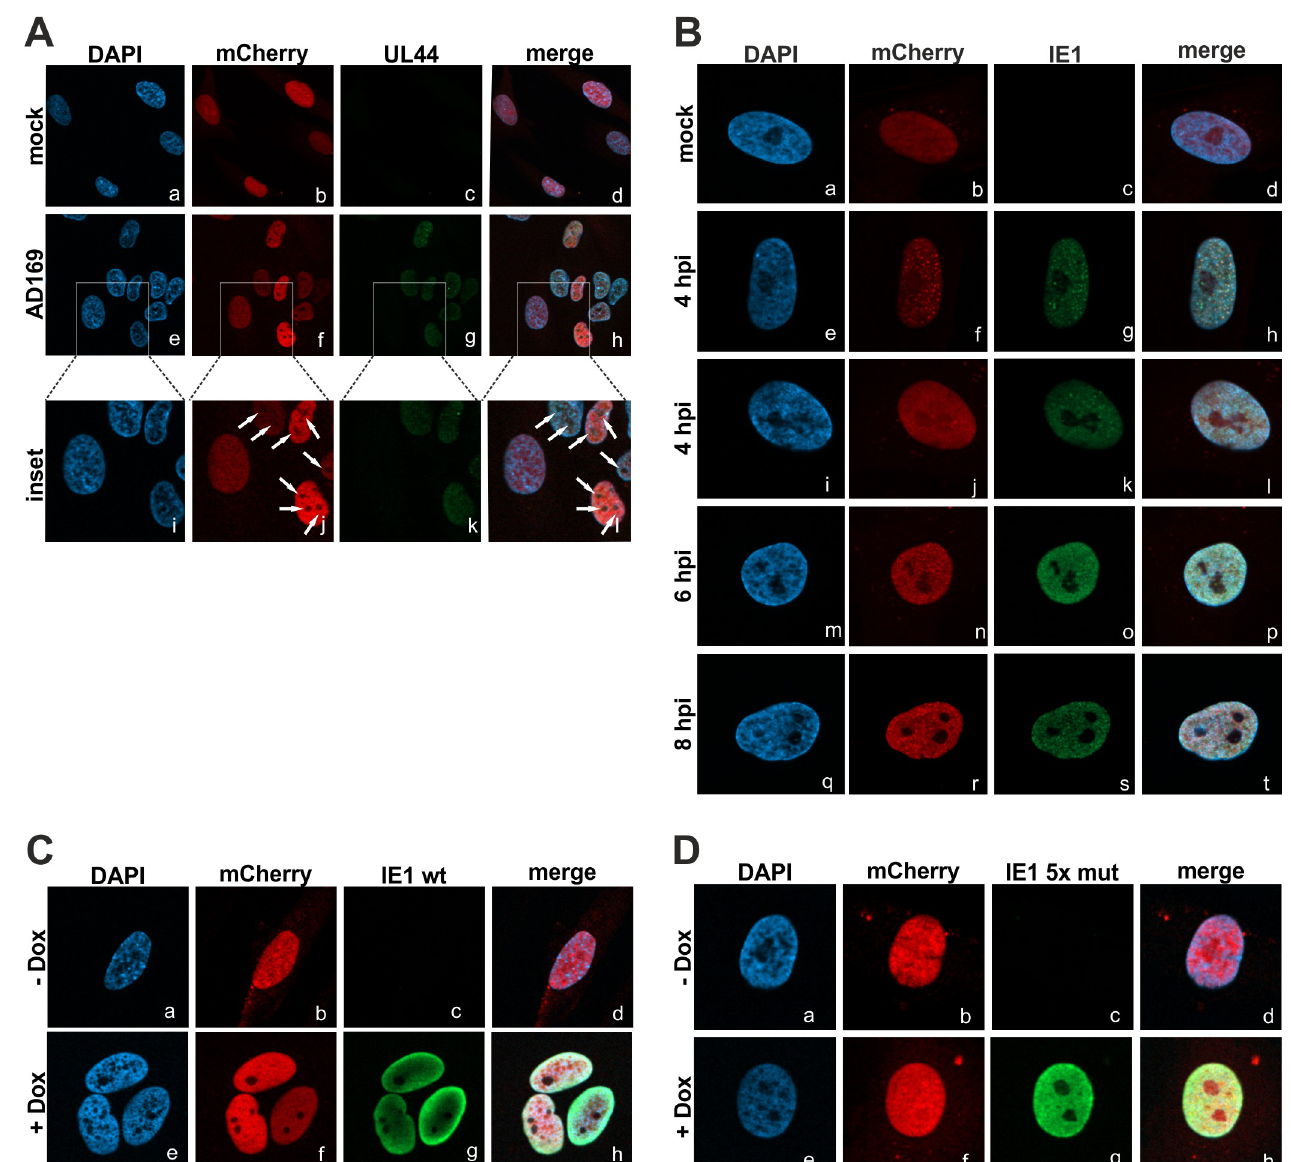
Fig 7. IE1-mediated nucleolar exclusion of FEN1 during HCMV infection. (A) mCherryFEN1 cells were infected with AD169 at an MOI of 1 and, at 24 hpi, analyzed by detecting the red fluorescent protein mCherry as well as UL44 as marker for infected cells by utilizing an antibody directed against UL44. Nucleoli are marked by arrowheads in the inset images. (B) mCherryFEN1 cells were infected with AD169 at an MOI of 1 and, at indicated time points, analyzed by detecting the red fluorescent protein mCherry as well as IE1 by utilizing an antibody directed against IE1. (C and D) Doxycycline-inducible HFF IE1 wildtype (wt) (C) and HFF IE1 5x mut (D) were transduced with mCherryFEN1. Cells treated (+ Dox) or untreated (- Dox) with doxycycline (0.5 μ g/ml) were analyzed by detecting the red fluorescent protein mCherry as well as IE1 by utilizing an antibody directed against